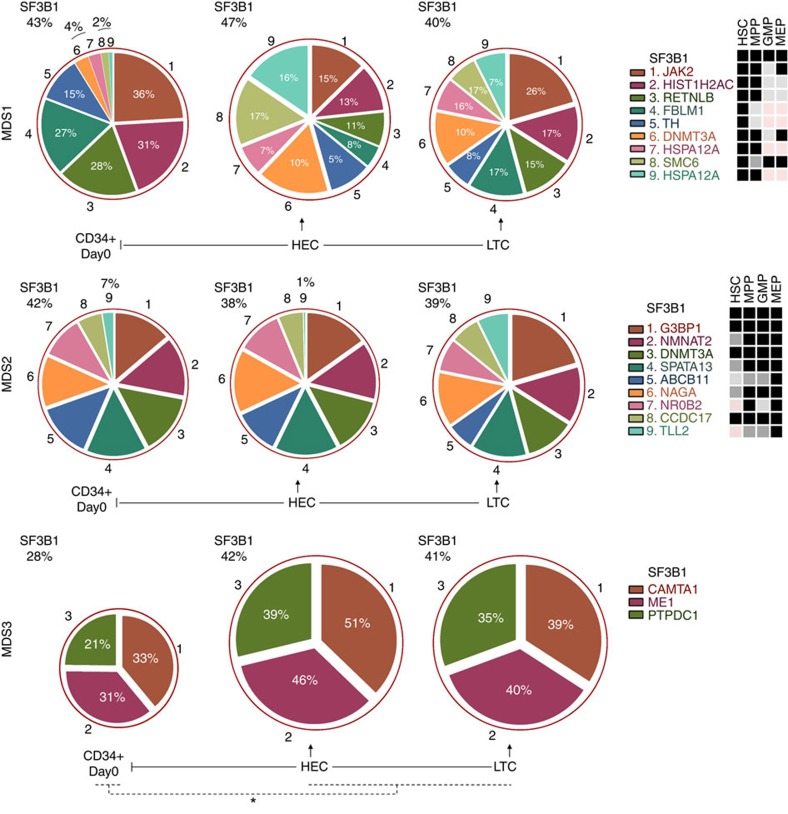
Mutational architecture and subclonal evolution of SF3B1-mutated MDS-RS bone marrow cells.Panels show the gene mutations with their MABs in primary CD34+ bone marrow, HEC cells and LTC samples from each patient. Outer red circle represents the total SF3B1 clone and the inner sections of the circle represents the SF3B1 subclones. MABs for HEC samples are the average of all mouse samples (where applicable, that is, >1 mouse). Percentages displayed in the pie chart indicate the MAB frequency modulation in HEC and LTC samples versus CD34+ day 0. *P<0.01% (t-test) for difference in SF3B1 MAB frequency between CD34+ day 0 and HEC and/or LTC samples for the MDS3 sample. For more details about statistical analysis of the variation in MAB frequencies, refer to Supplementary Fig. 5. The table on the right side of each panel represents the mutation status of the respective genes in the HSC, MPP, GMP and MEP cell populations for each patient. Samples used to isolate cell fractions (HSCs, MPPs, GMPs and MEPs) were taken ∼18 months later than the first sample used to isolate CD34+ cells. Three independent PCRs were performed to confirm/determine the MAB throughout the experiments. In the tables on the right side, the black boxes indicate that MAB for gene mutations was the same as the primary CD34+ cells, dark grey boxes show MAB for gene mutations that was≤2-fold as compared to the primary CD34+ cells, light grey boxes represent MAB for gene mutations that was ≥2-fold as compared with the primary CD34+ cells and pink boxes indicate not detected or below background noise level. MAB mutant allele burden; HEC, human engrafted cell; LTC, long-term culture; BM, bone marrow; Mut, mutation.